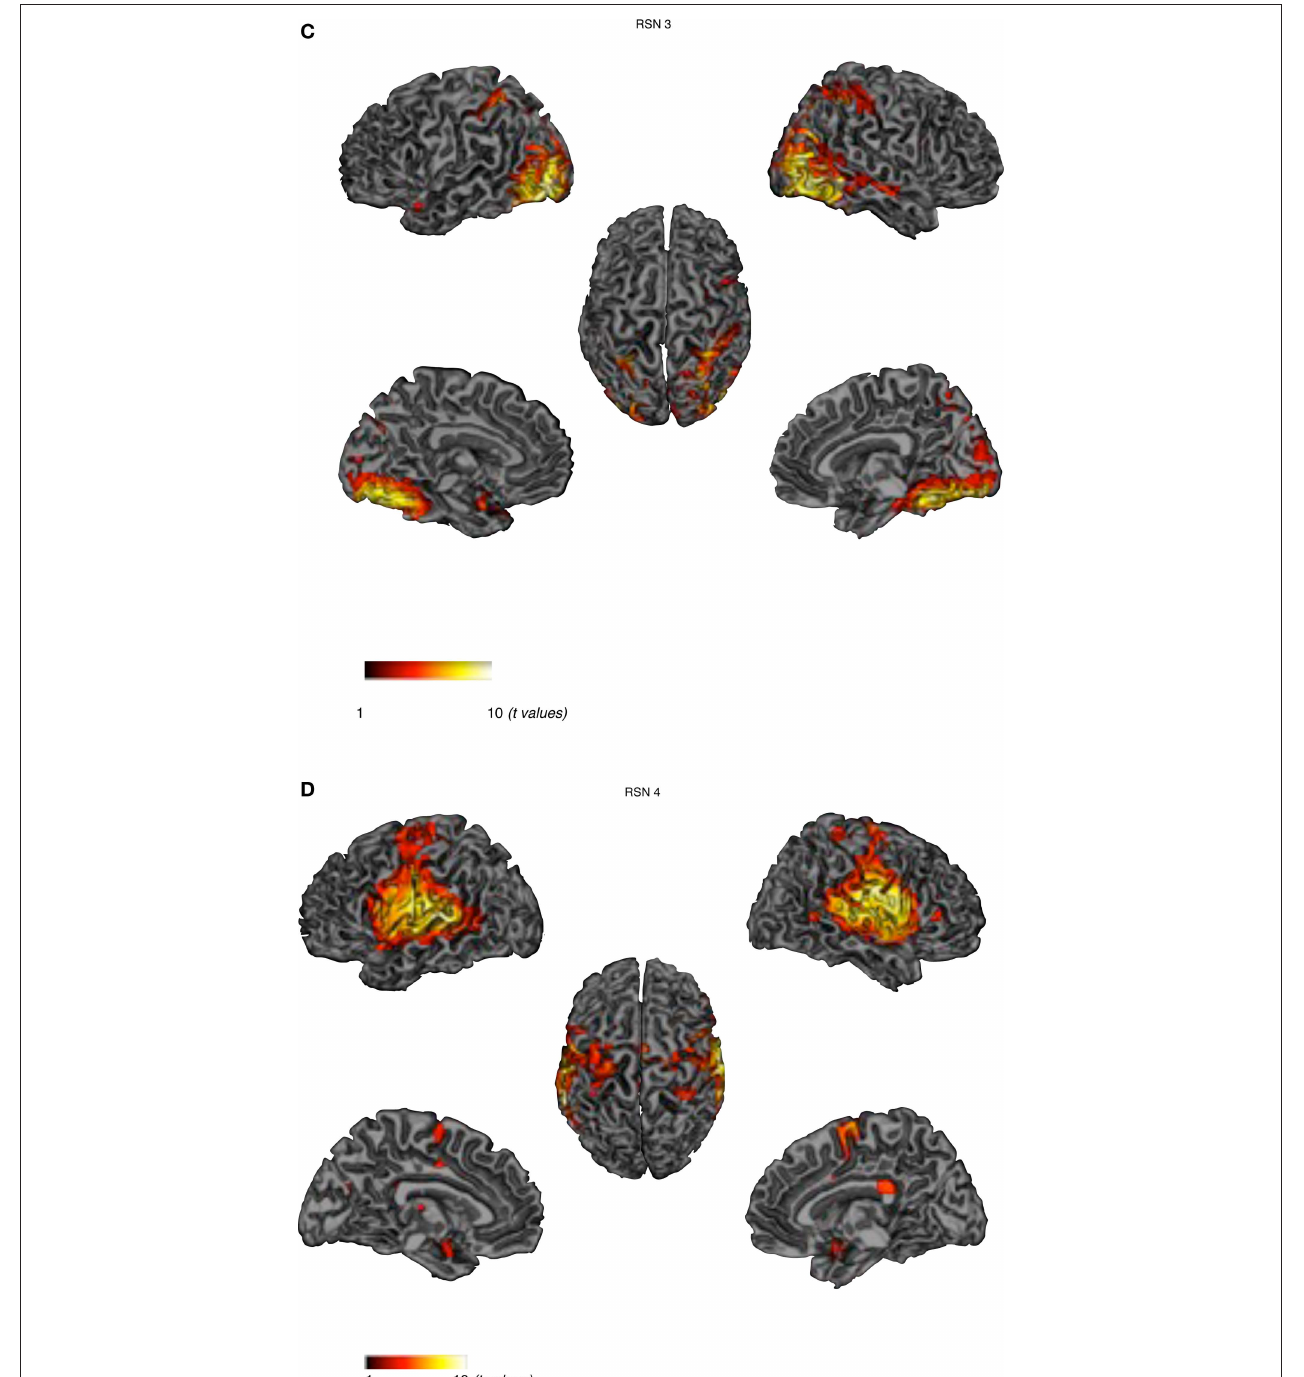
FIguRe 1 | Cortical representation of the activity in the six RSNs. For each RSN (Left) Lateral and medial views of left hemisphere. (Center) Dorsal view. (Right) Lateral and medial views of right hemisphere. (C) visual network – VN, (D) auditory network – AN.